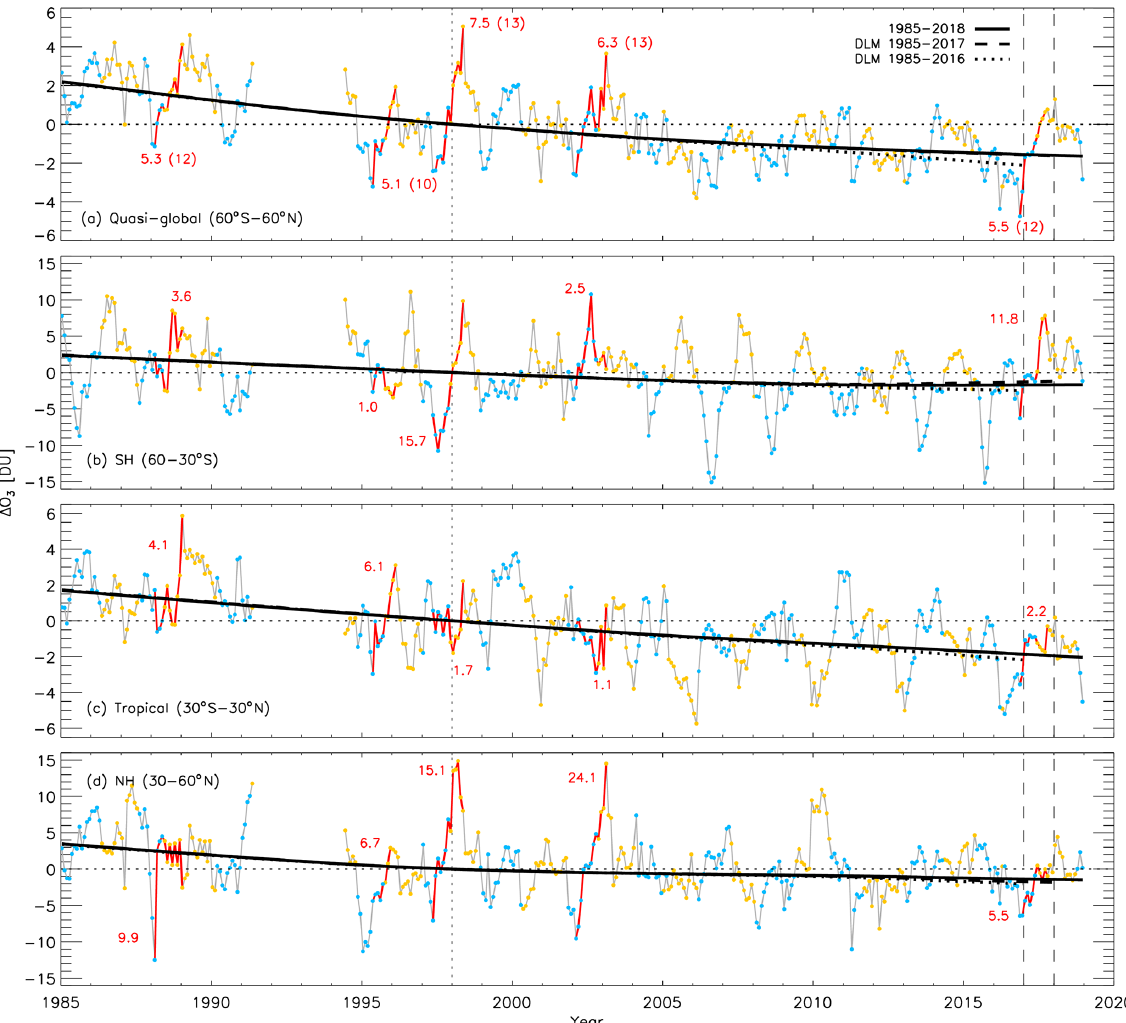
Figure 2. Lower stratospheric partial column ozone anomalies: (a) quasi-global (60 ◦ S–60 ◦ N), (b) Southern Hemisphere (60–30 ◦ S, 147– 30hPa), (c) tropics (30 ◦ S–30 ◦ N, 100–30hPa), and (d) Northern Hemisphere (30–60 ◦ N, 147–30hPa). The DLM non-linear trend is shown for 1985–2016 (dotted), 1985–2017 (dashed), and 1985–2018 (solid). Red lines represent contiguous periods identified in the quasi-global anomalies exceeding 90% of the magnitude of the November 2016 to October 2017 change within a 13-month period; the DU changes are written above or below each period; red periods in (b–d) are those identified in (a) . Coloured dots are plotted on each time series when the QBO at 30hPa is either in an easterly (yellow) or westerly (blue) phase. The 3-year period following the eruption of Mt. Pinatubo, June 1991 to May 1993, has been removed. Figures for the whole, upper, and middle stratosphere are provided in Figs. S2–S4 in the